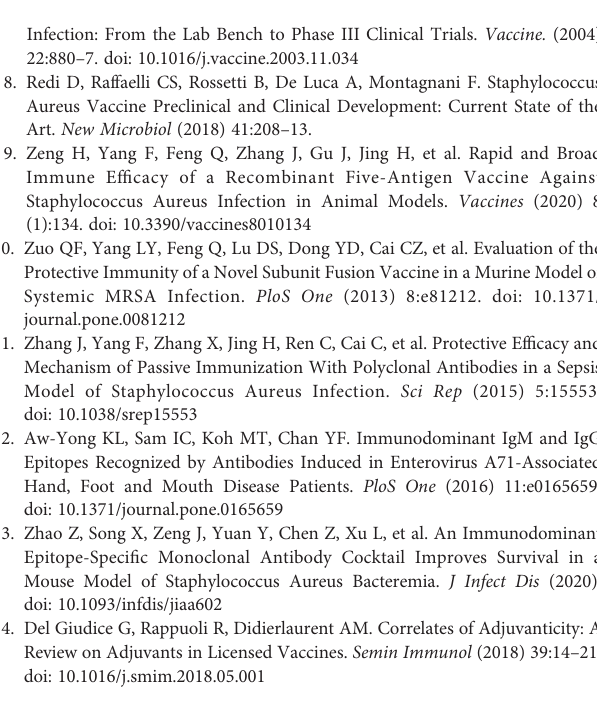
Supplementary Figure 1 | The protective ef fi cacy of immunization with each single immunodominant epitope-KLH formulated with AlPO 4 against MRSA252 challenge. Percent survival in mice immunized with every single immunodominant epitope-KLH plus AlPO 4 adjuvant, AlPO 4 alone or PBS was used as control (n